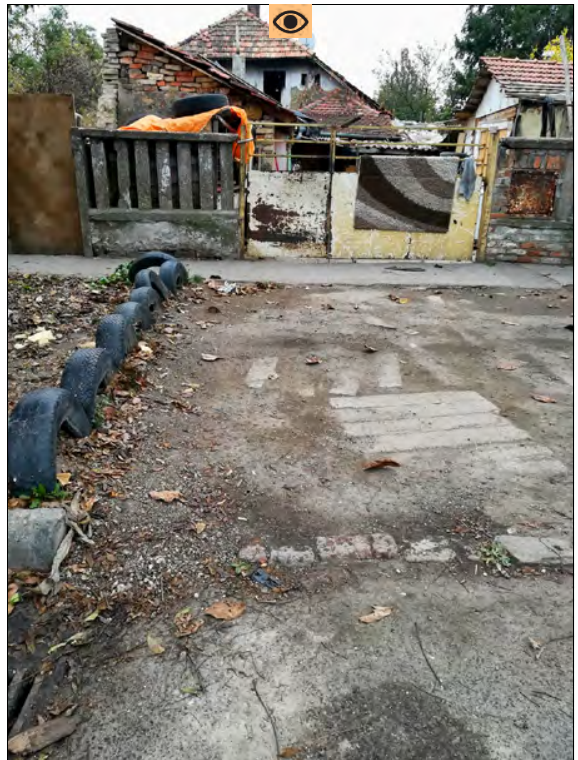
Figure 2. Roma housing conditions in Szeged Source: Méreiné Berki’s photo